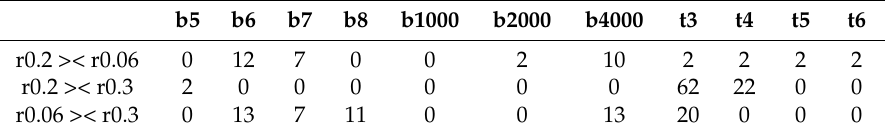
Table 9. Significant difference scores (%) between the three search radius (laboratory study). Table 8. Significant difference scores (%) between the three search radius (field